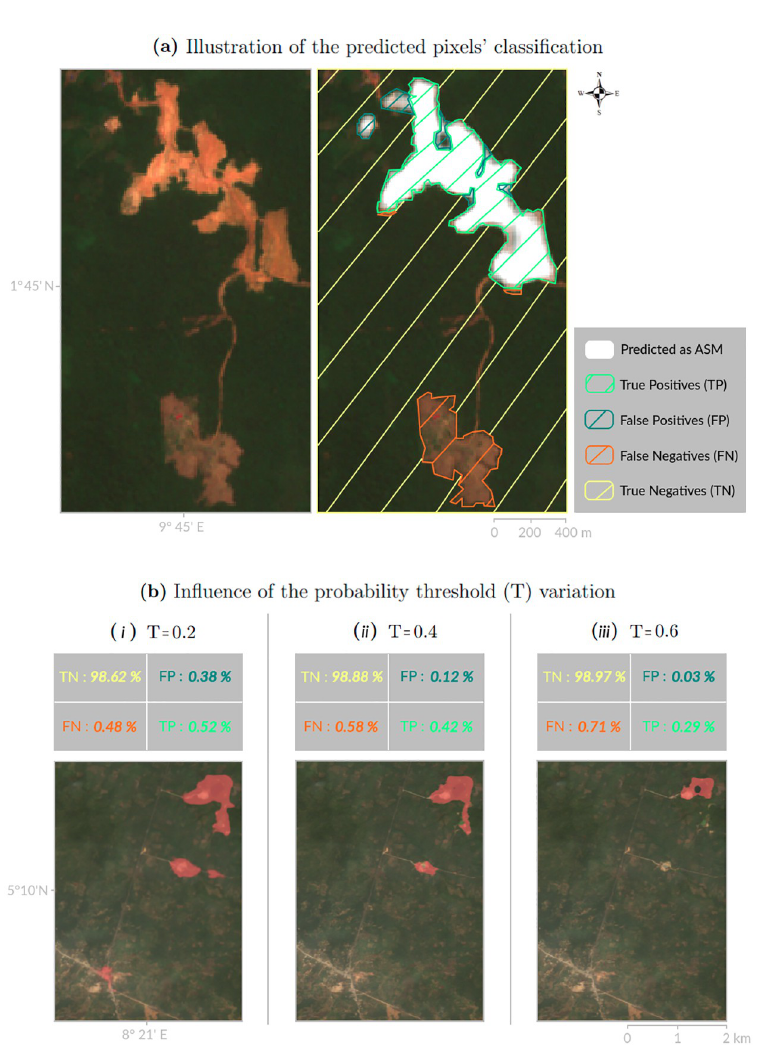
Fig 2. Classification of the predictions: Illustrations. (a) Illustration of the standard pixels classification derived from the comparison between prediction and reality (TP, FP, FN and TN, together forming the confusion matrix) from a sub-sample of our predicted test set in the region of Bata, Equatorial Guinea. (b) Confusion matrices computed for three distinct scenarios (defined in section Performances along probability threshold value). It comes with an illustration of the binary prediction (red shapes) performed for the corresponding T value, in the region of New Netim (Nigeria). Note that figures are computed for the whole test set , contrary to the sample images that aim to illustrate the effect of the T value variation on a relevant area. Sources: Sentinel-2 (from the Copernicus program) & author calculations .